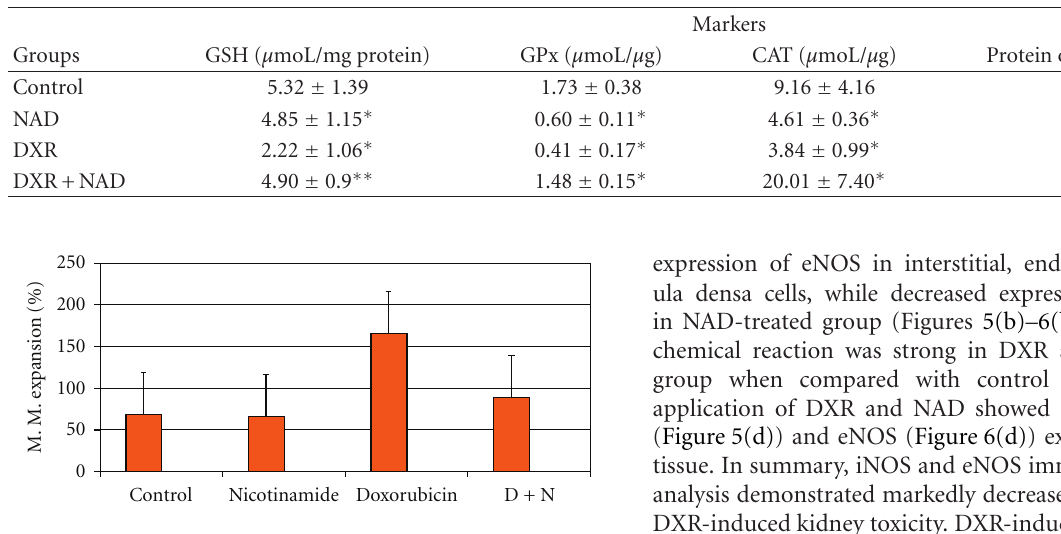
Table 1: The activities of catalase (CAT), glutathione peroxidase (GPx), glutathione (GSH), and protein oxidation (Po) levels in renal tissue of control ( n = 6), NAD ( n = 8), DXR ( n = 8), and DXR plus NAD groups ( n = 8). ∗ P = 0 . 001; control versus NAD, DXR, and N+D, ∗∗ P = 0 . 105; control versus N+D.